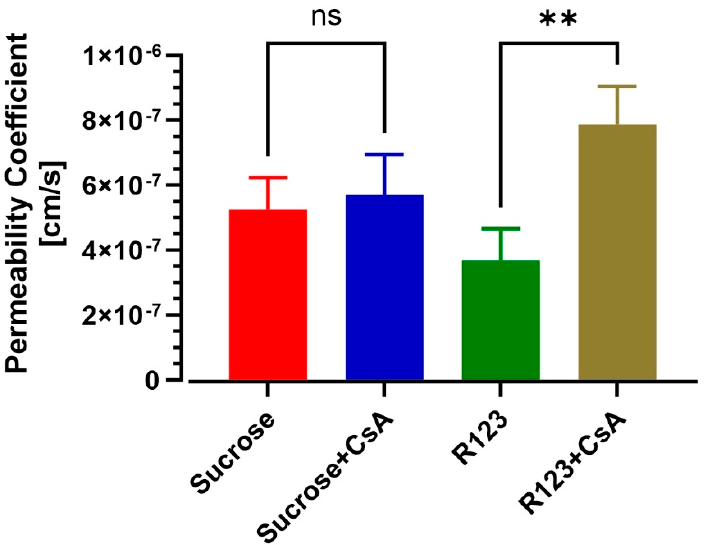
Figure 5. Assessment of efflux transporter functionality of iBMECs in BBB on a chip with and without cyclosporine A treatment. Note the permeability coefficient of rhodamine 123 (substrate of P-gp transporter) and sucrose in the presence or absence of the P-gp inhibitor ( n = 3 biological replicates). ** p < 0.01, assessed by one-way ANOVA, followed by Tukey’s multiple comparisons test.